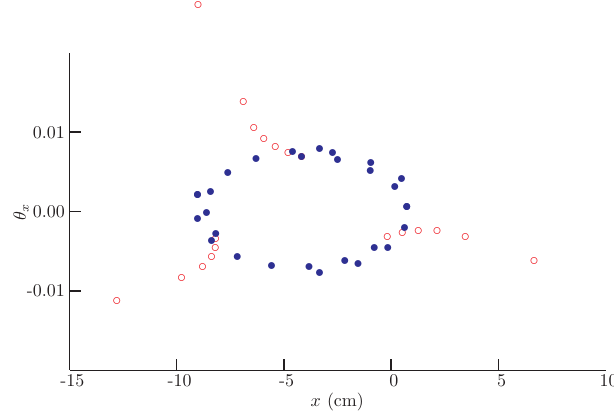
FIG. 35. (Color) Tracking of a particle at the edge of the acceptance with uniform acceleration. The dashed line is without any body sextupole, and the solid line is with the corrected body sextupole.